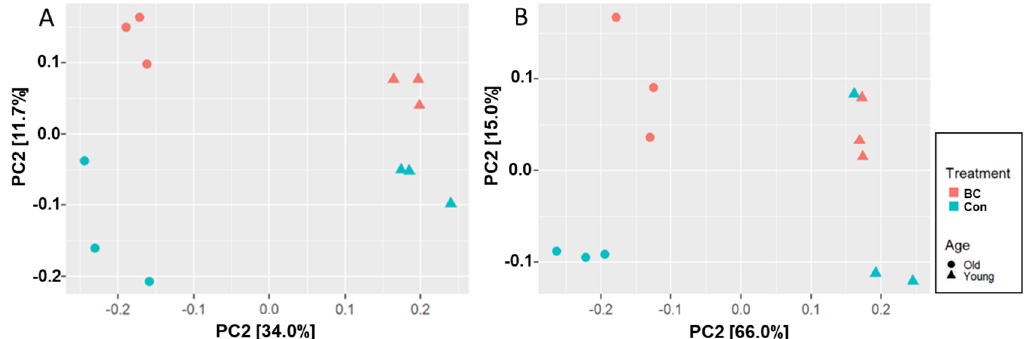
Figure 2. Principal coordinate analysis of microbial samples based on age and diet. ( A ) Unweighted and ( B ) weighted UniFrac distance. Young control (green triangle), young BC (orange triangle), old control (green circle), and old BC (orange circle).